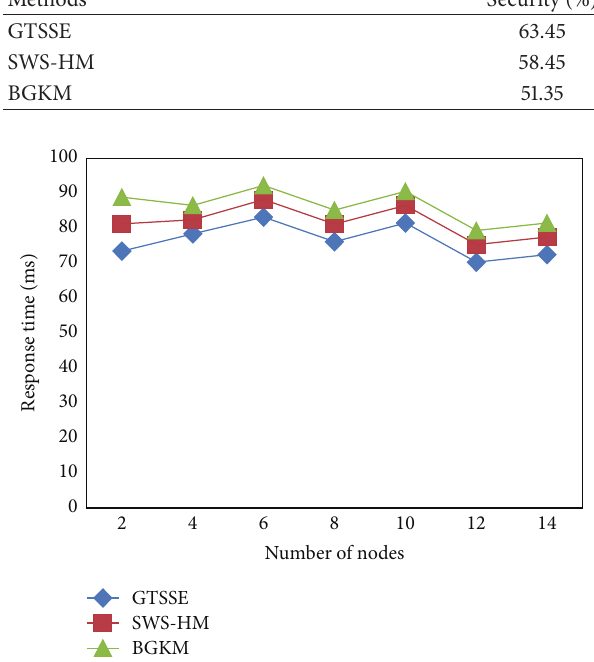
Figure 5: Response time for three methods, GTSSE, SWS-HM, and